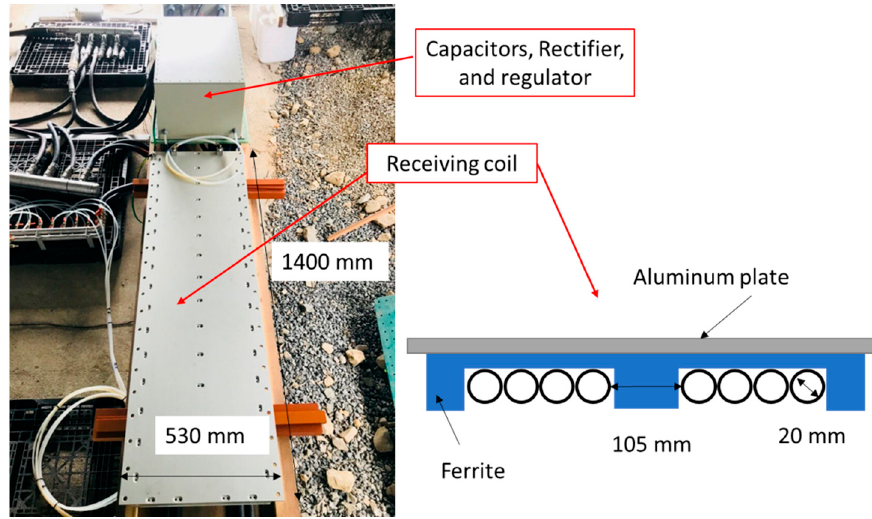
Figure 3. Structure of the pick-up.